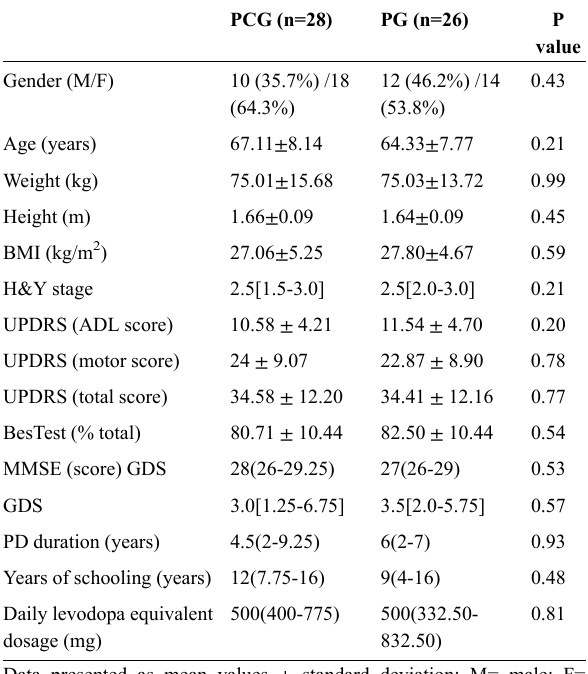
Table 1 - Subjects characteristics (cid:0)